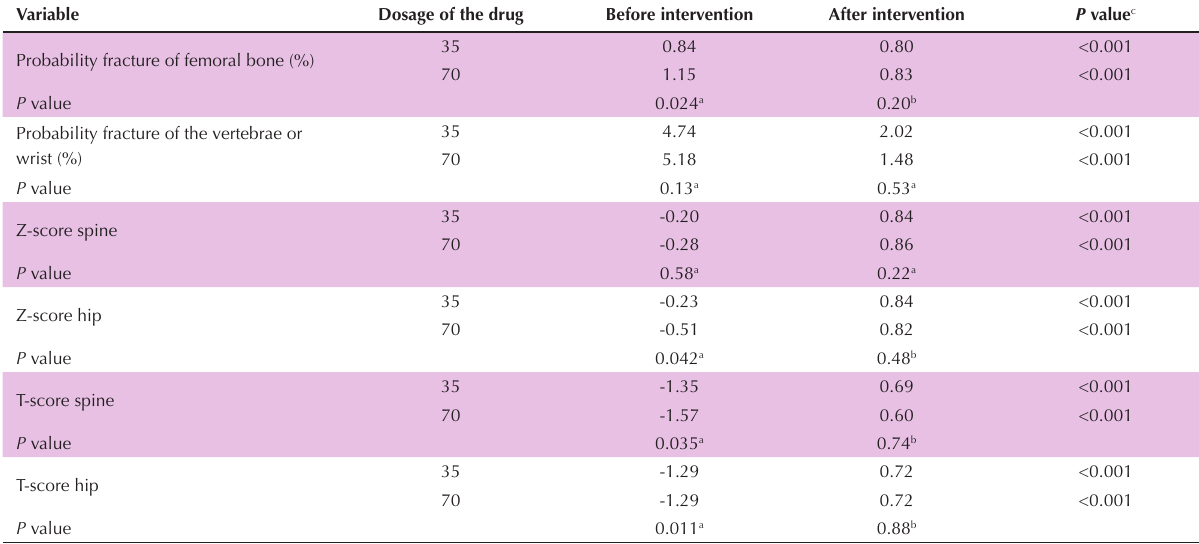
Table 2. Comparison of mean fracture risk in two groups with 35 and 70 mg of alendronate before and after intervention Variable Dosage of the drug Before intervention After intervention Probability fracture of femoral bone (%)